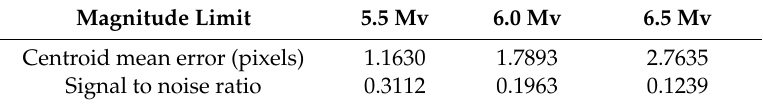
Figure 7. ( a ) Signal-to-noise ratio; ( b ) mean error of a centroid as a function of rates. Table 5. Centroid accuracy and signal-to-noise ratio at 10 deg/s angular rate. Table 5. Centroid accuracy and signal-to-noise ratio at 10 deg / s angular rate.